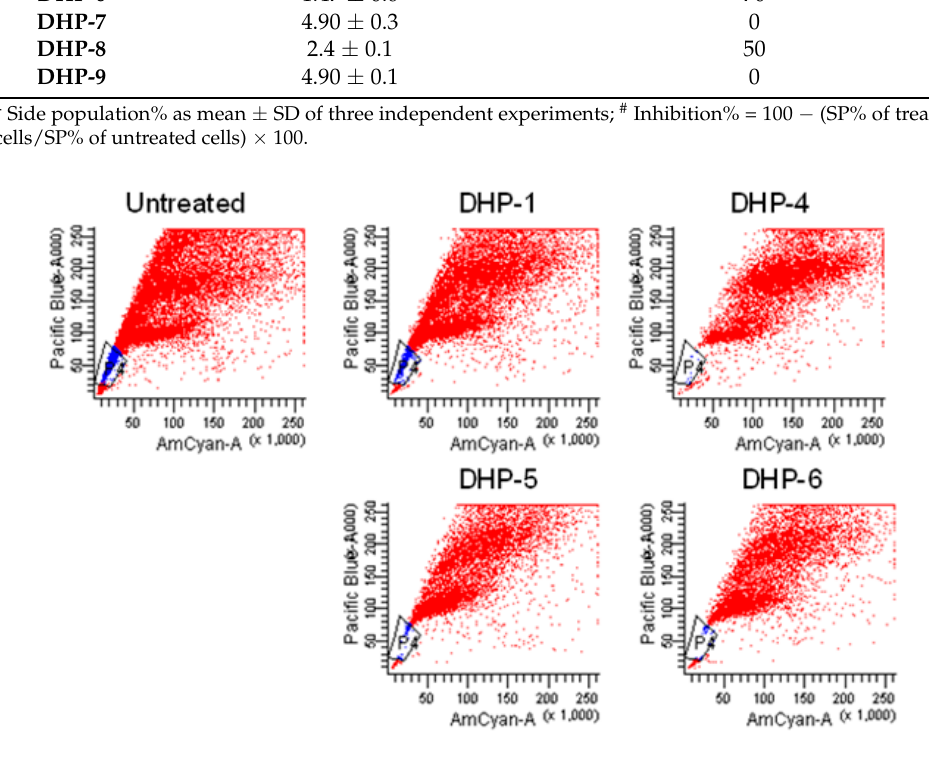
Figure 3. Scatter plot showing results of side population analyses of tumor-derived cells of LOVO untreated, treated with DHP-1 , DHP-4 , DHP-5 and DHP-6 . Furthermore, compound DHP-5 exhibit an in vitro anti-proliferative effect and arrested cancer cells at the G2 checkpoint (Figure 4). Blue color represents the percentage of cancer stem cells and red color represents the percentage of remaining cells other than cancer stem cells.